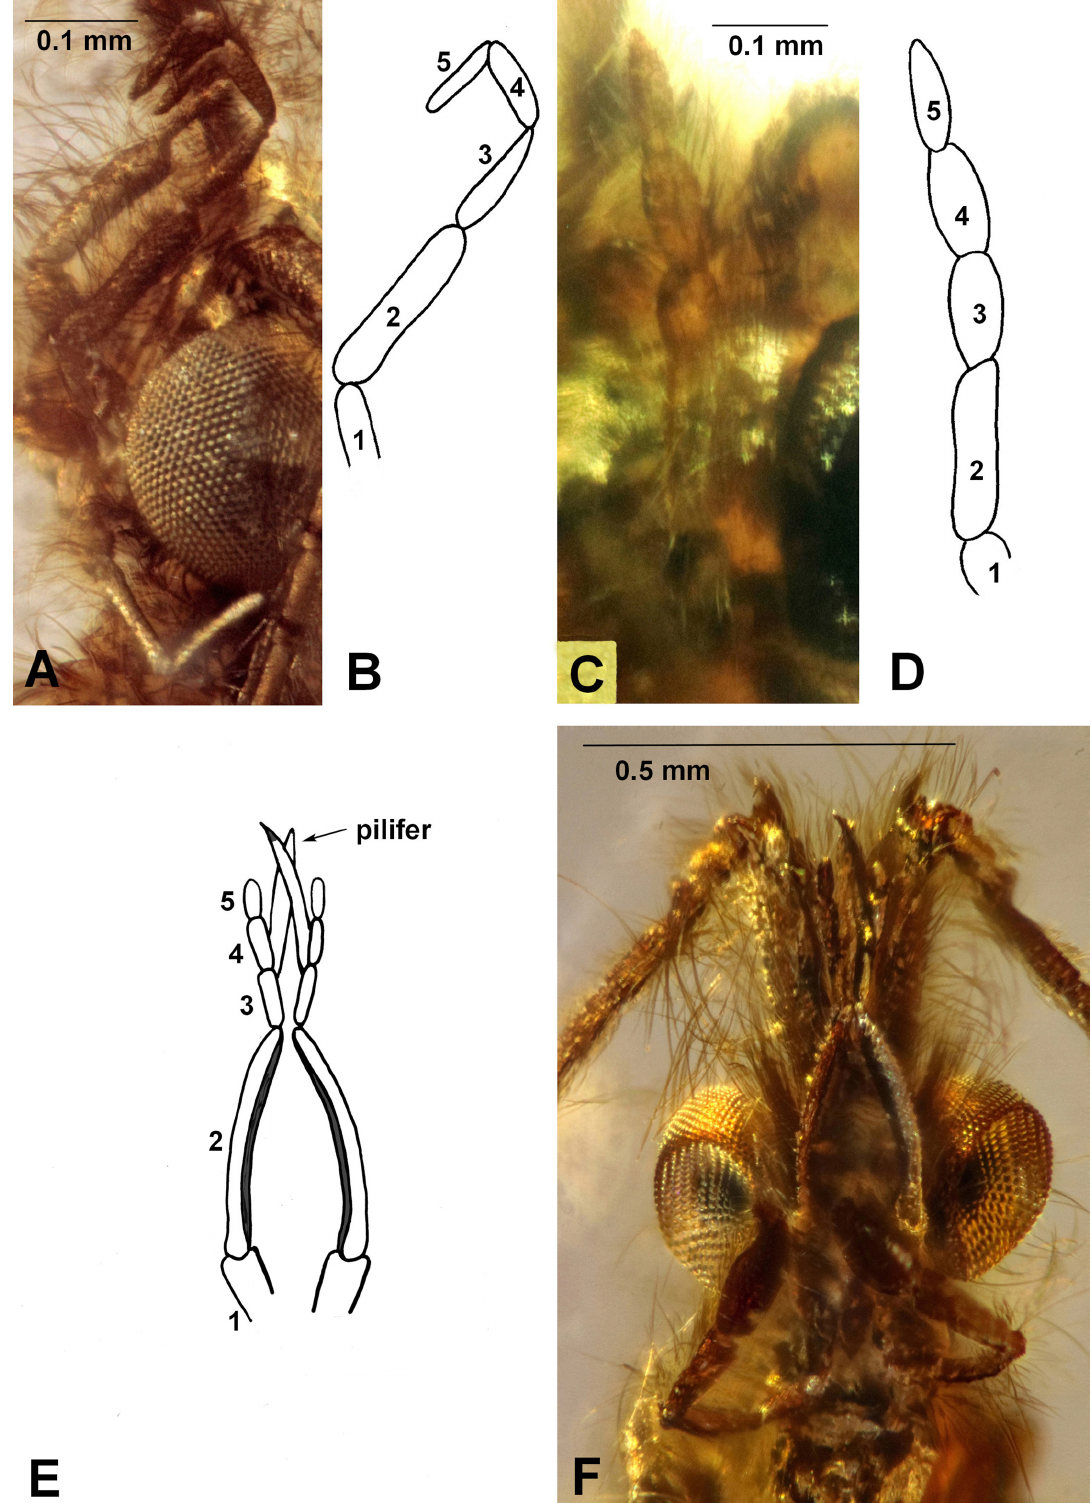
Fig. 2. The 5-segmented maxillary palps of species of Cretapsyche Wichard, Neumann, Müller &